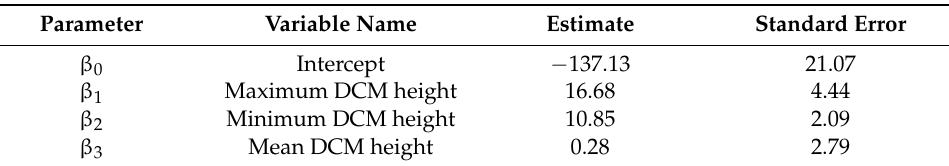
Table 5. The results of multiple-regression analysis for the model in Equation (2) using the AGB F obtained from a field survey and the LiDAR-derived variables, namely the intercept ( β 0 ) and the maximum ( β 1 ), minimum ( β 2 ), and mean ( β 3 ) DCM heights for the sample plots.